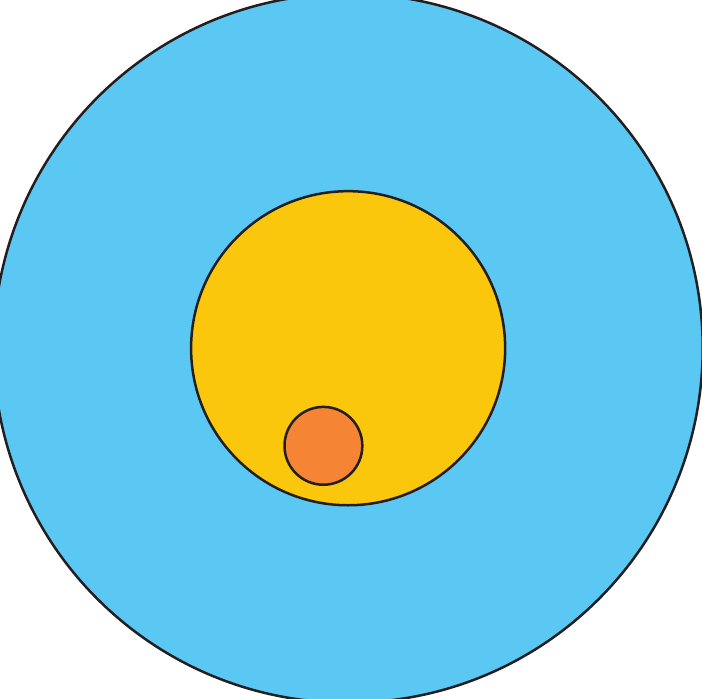
Figure 5: Second scenario: tumor located inside the fibroglandular